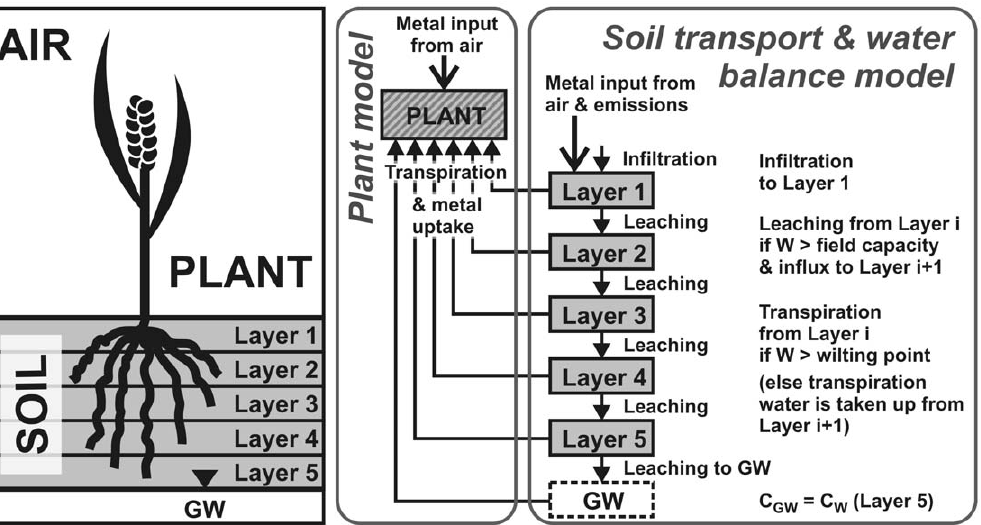
Figure 7. Processes and compartments in the coupled soil solute transport, water balance and plant uptake model. W: water content, GW: groundwater, C GW : groundwater concentration, C W : soil pore water concentration.